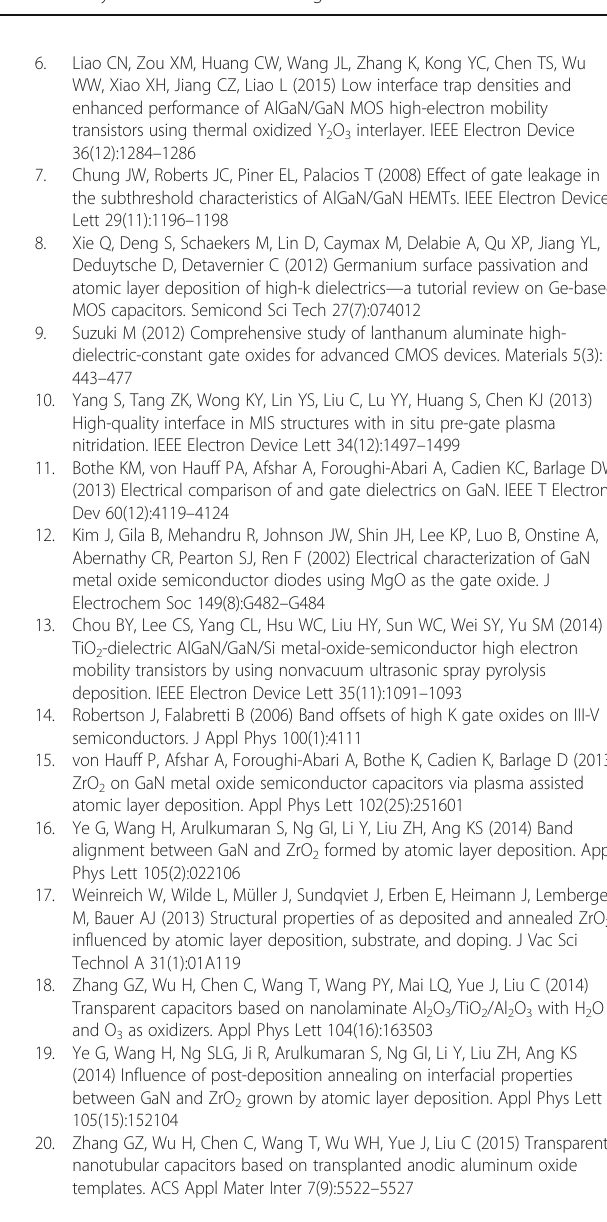
Fig. 7 The conductive mechanism of MOS capacitors annealed at 500 °C. a Schottky emission. b F-N